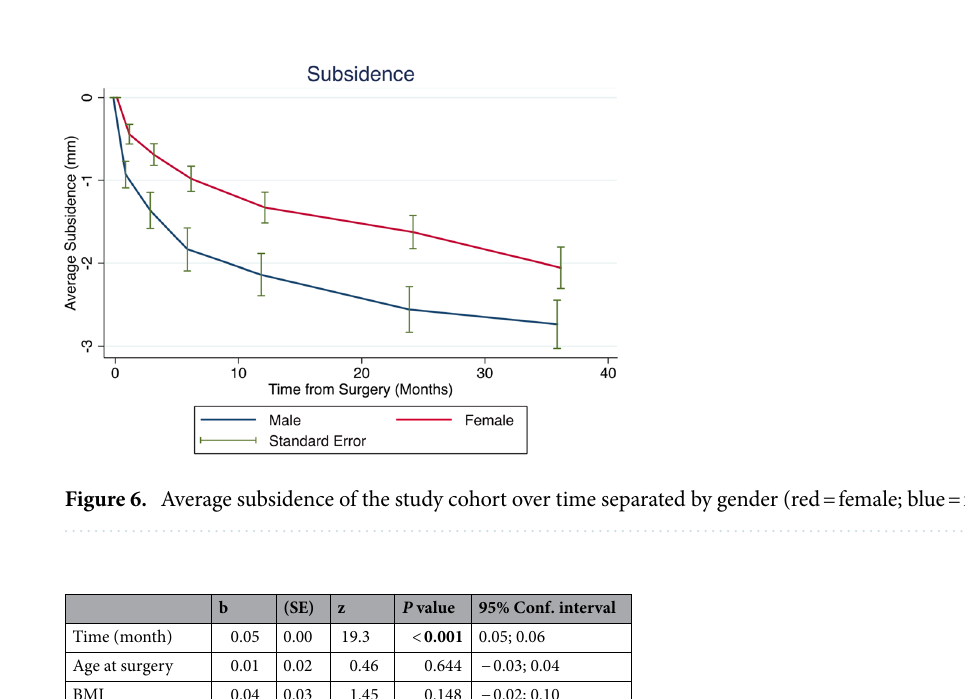
Figure 5. Average subsidence of the study cohort over time.